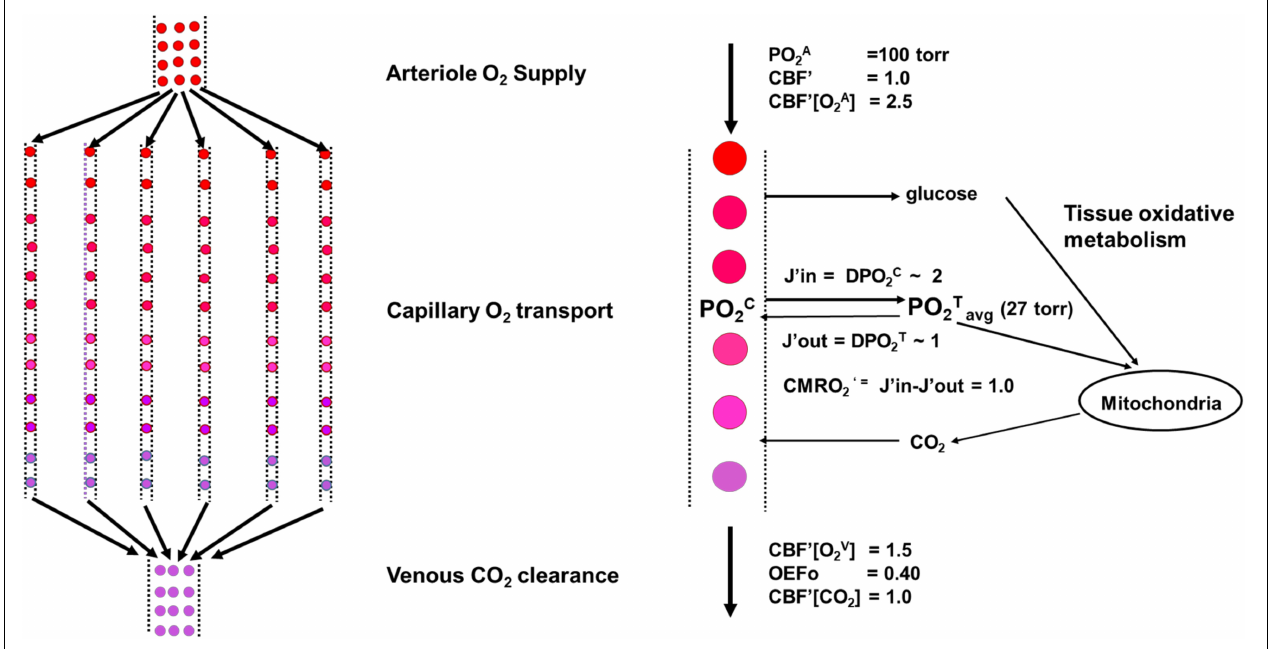
FIGURE 3 | Schematic of the model in the undisturbed awake